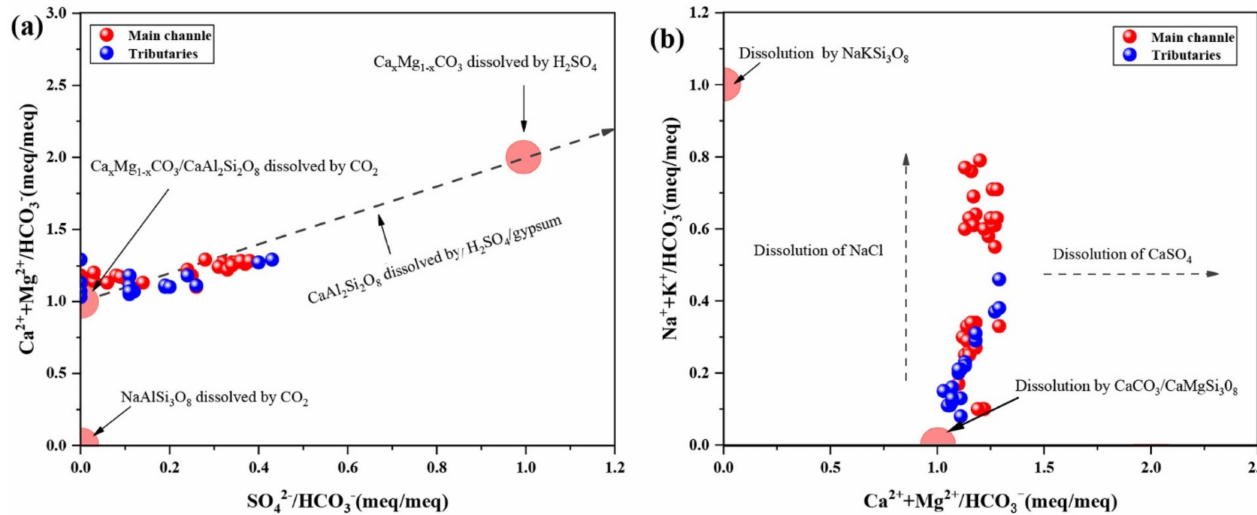
Figure 5. Possible weathering process diagram of ions. ( a ) the ratios of Ca 2+ + Mg 2+ and SO 42 − to HCO 3 − , respectively; ( b ) ratios of Na + + K + /HCO 3 − and Ca 2+ + Mg 2+ /HCO 3 −